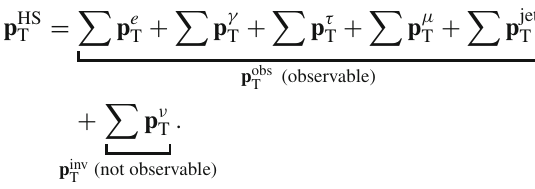
the reconstructed Z boson, i.e. p hard Fig. 12a. The uncertainties are determined by comparing P (cid:7) and P ⊥ spectra from data and MC simulations, in bins of p hard For P (cid:7) , the smearing of the response and the width both yield scale and (longitudinal) resolution offsets. In the case of P ⊥ , only smearing of the width is applied to provide trans- verse resolution offsets. These fitted offsets, determined for